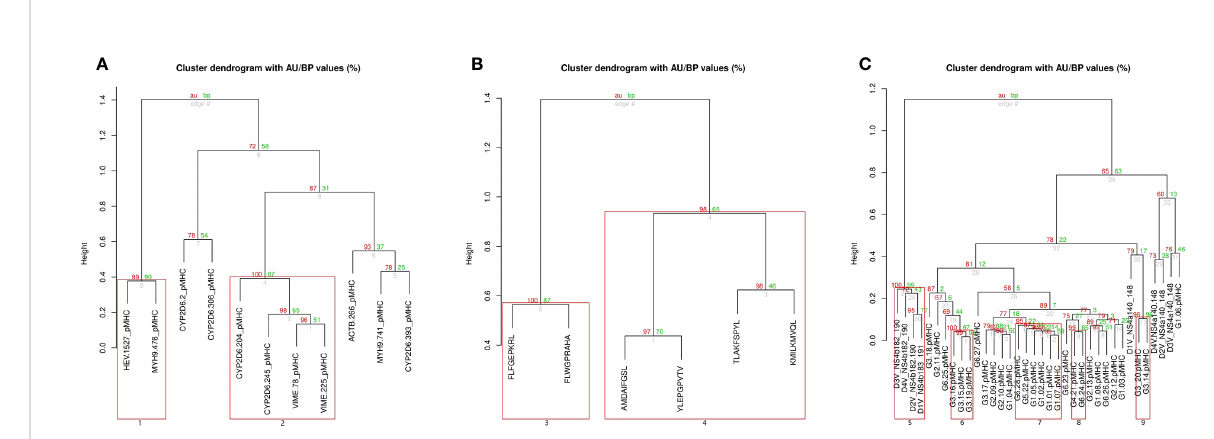
FIGURE 3 The fi nal result of MatchTope analysis: Hierarchical clustering is represented in a tree-based format. Pvclust provides two types of p-values: AU (Approximately Unbiased, red color) p-value and BP (Bootstrap Probability, green color) value. Branches inside red squares have an AU p-value higher than 95%, indicating a signi fi cant similarity between pMHCs clustered in that branch. There are three different clusters matching the different data sets used for MatchTope validation. (A) is related to the Hepatitis E Virus (HEV)-Speci fi c T Cell Receptor study, (B) is the cluster from the throat cancer study, and (C) combines the clustering from the HCV and Dengue studies. Groups 1, 3, 5, 7, and 8 clustered epitopes that have cross-reactivity con fi rmed by in vitro data. Supplementary Table 1 presents the epitope list and which epitopes similarly trigger cross